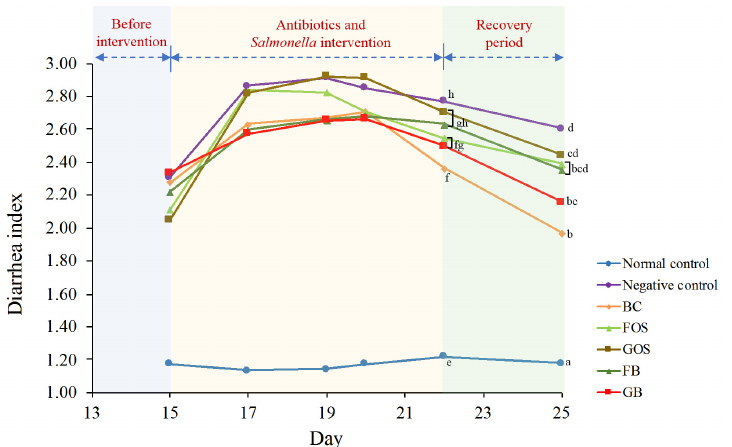
Figure 4. Changes in diarrhea index among different animal groups. Blue zone (days 13 to 14) indicates the period before intervention. Yellow zone (days 15 to 22) indicates the period of antibiotics intervention and Salmonella infection. Green zone (days 23 to 25) indicates the recovery period. Mean values on the curves bearing different letters (e–h) indicate significant differences ( p < 0.05) among different groups on day 22. Mean values on the curves bearing different letters (a–d) indicate significant differences ( p < 0.05) among different groups on day